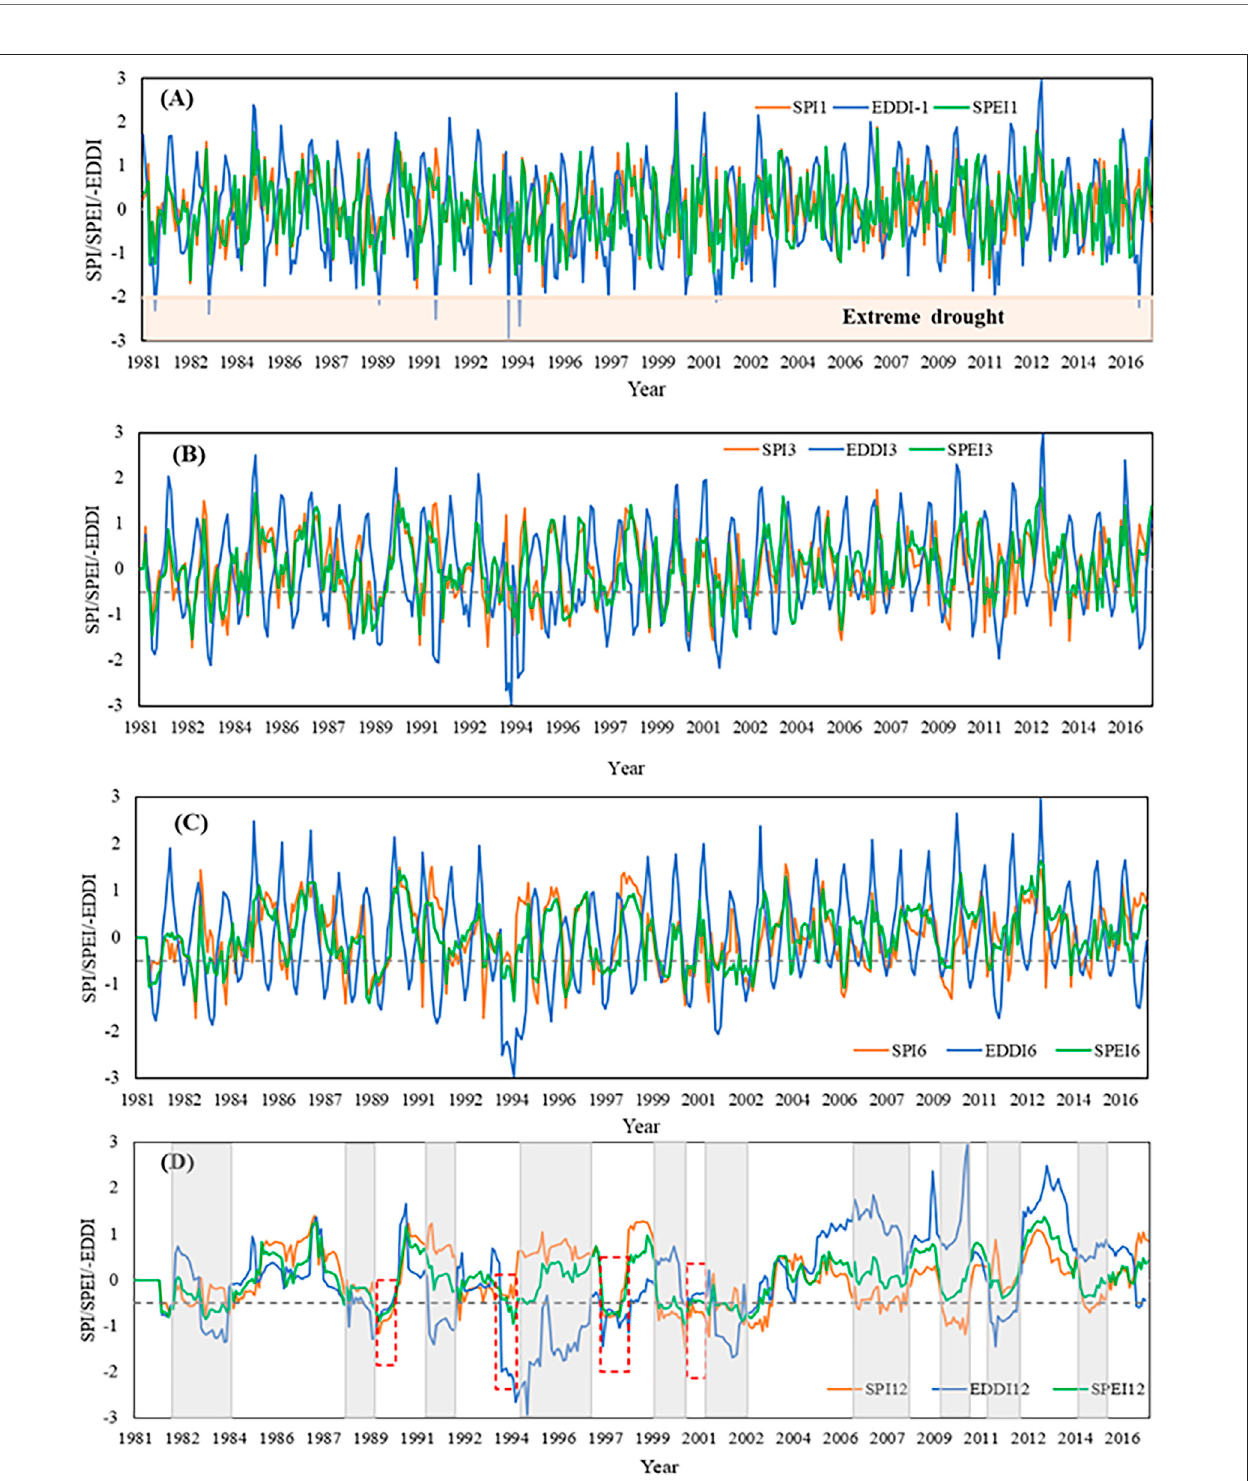
FIGURE 2 | Temporal evolution of the SPI, SPEI, and EDDI for 1-month (A) , 3-month (B) , 6-month (C) , and 12-month (D) timescales. It is noted that the shaded arearepresentstherangeoftheextremedroughtconditions(SPEI,SPI,andEDDI ≤ -2);theblackdottedlinesrepresentthedividinglinebetweenwetanddroughtstates (the value is − 0.5); the grey shaded areas highlight when the three indices have opposite states; and the red wireframe indicates when the three indices identify different drought levels.